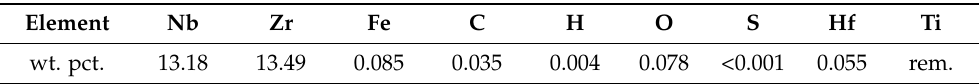
Table 1. Chemical composition of the Ti13Nb13Zr alloy.